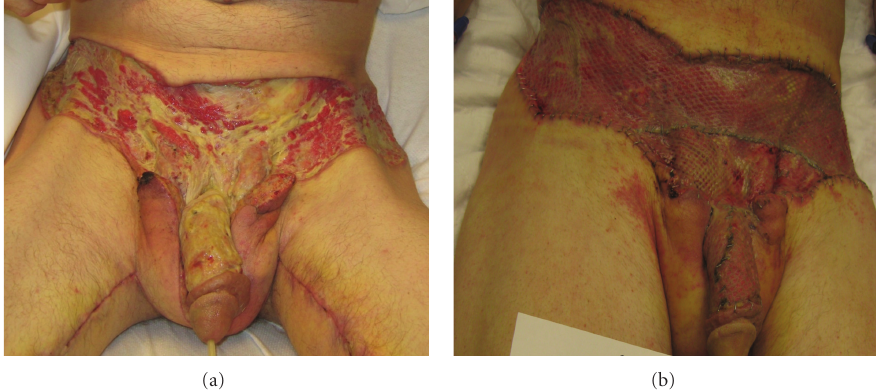
Figure 4: Reconstruction of Fournier’s gangrene wound: (a) bilateral medial thigh fasciocutaneous flaps for scrotal reconstruction were performed; (b) cadaveric skin graft of the penis and lower abdomen was necessary for temporary wound